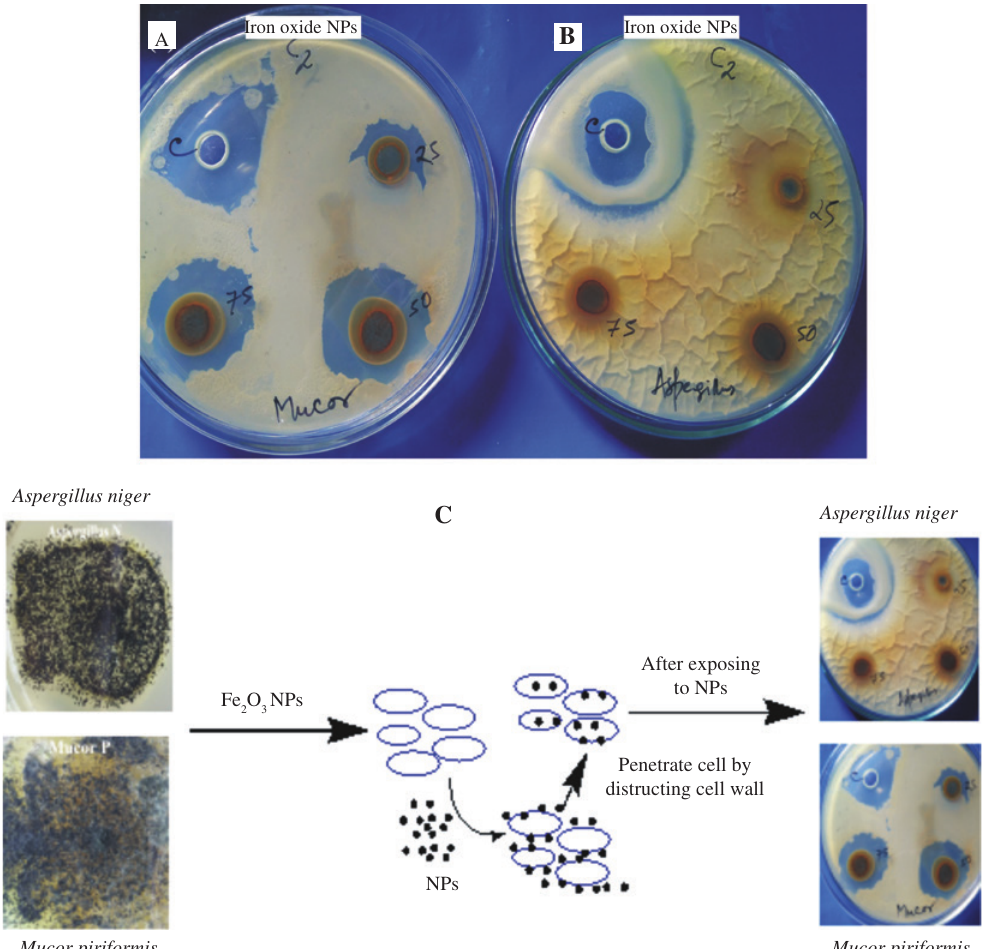
Figure 8: Antifungal activity of iron oxide nanoparticles against (A) Mucor piriformis , (B) Aspergillus niger , and (C) diagrammatic presenta- tion of the antifungal